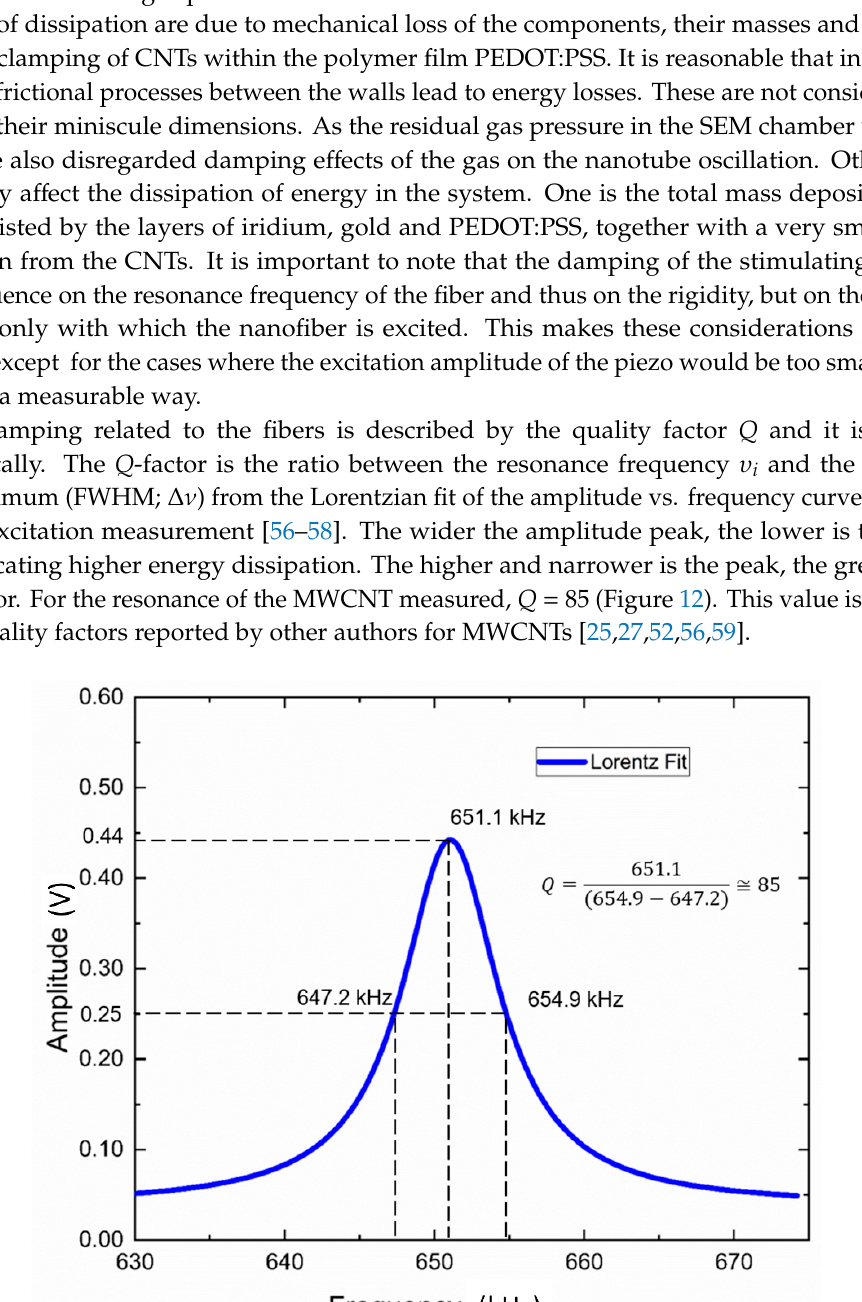
= 85. Applied voltage of ν (cid:2940)(cid:2973)